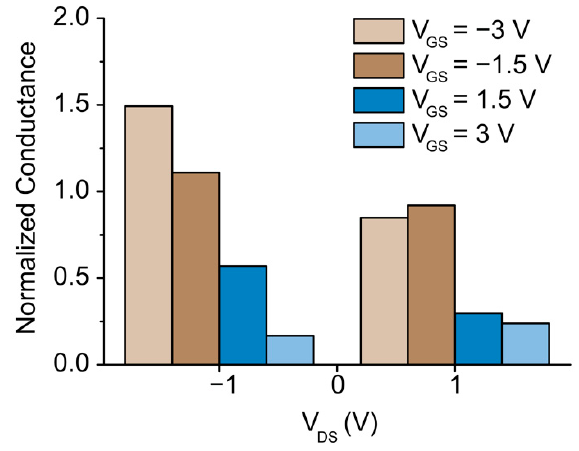
Figure 7. Normalized conductance for 10 − 4 M KCl, defined as the ratio of the conductance after ap- plication of the gate voltage to the conductance measured with a floating gate for V DS = − 1 V and V DS = 1 V.